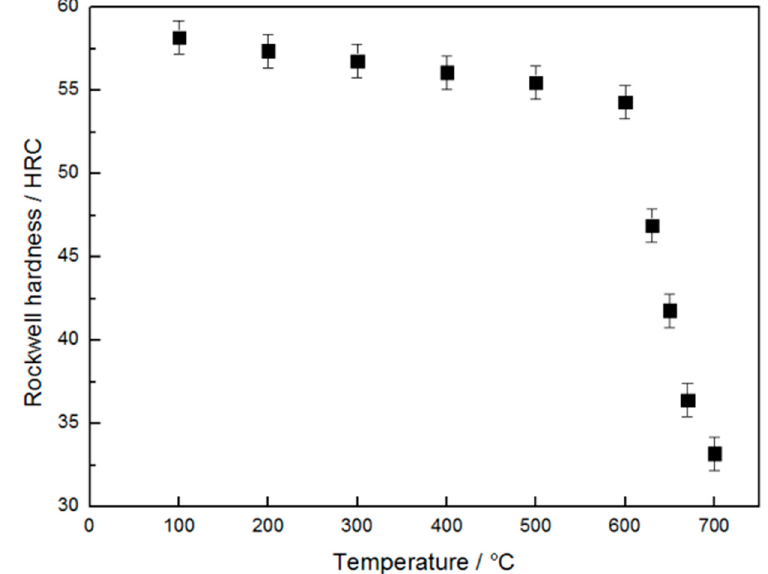
Figure 7. Rockwell hardness of H13 steel at high temperature.